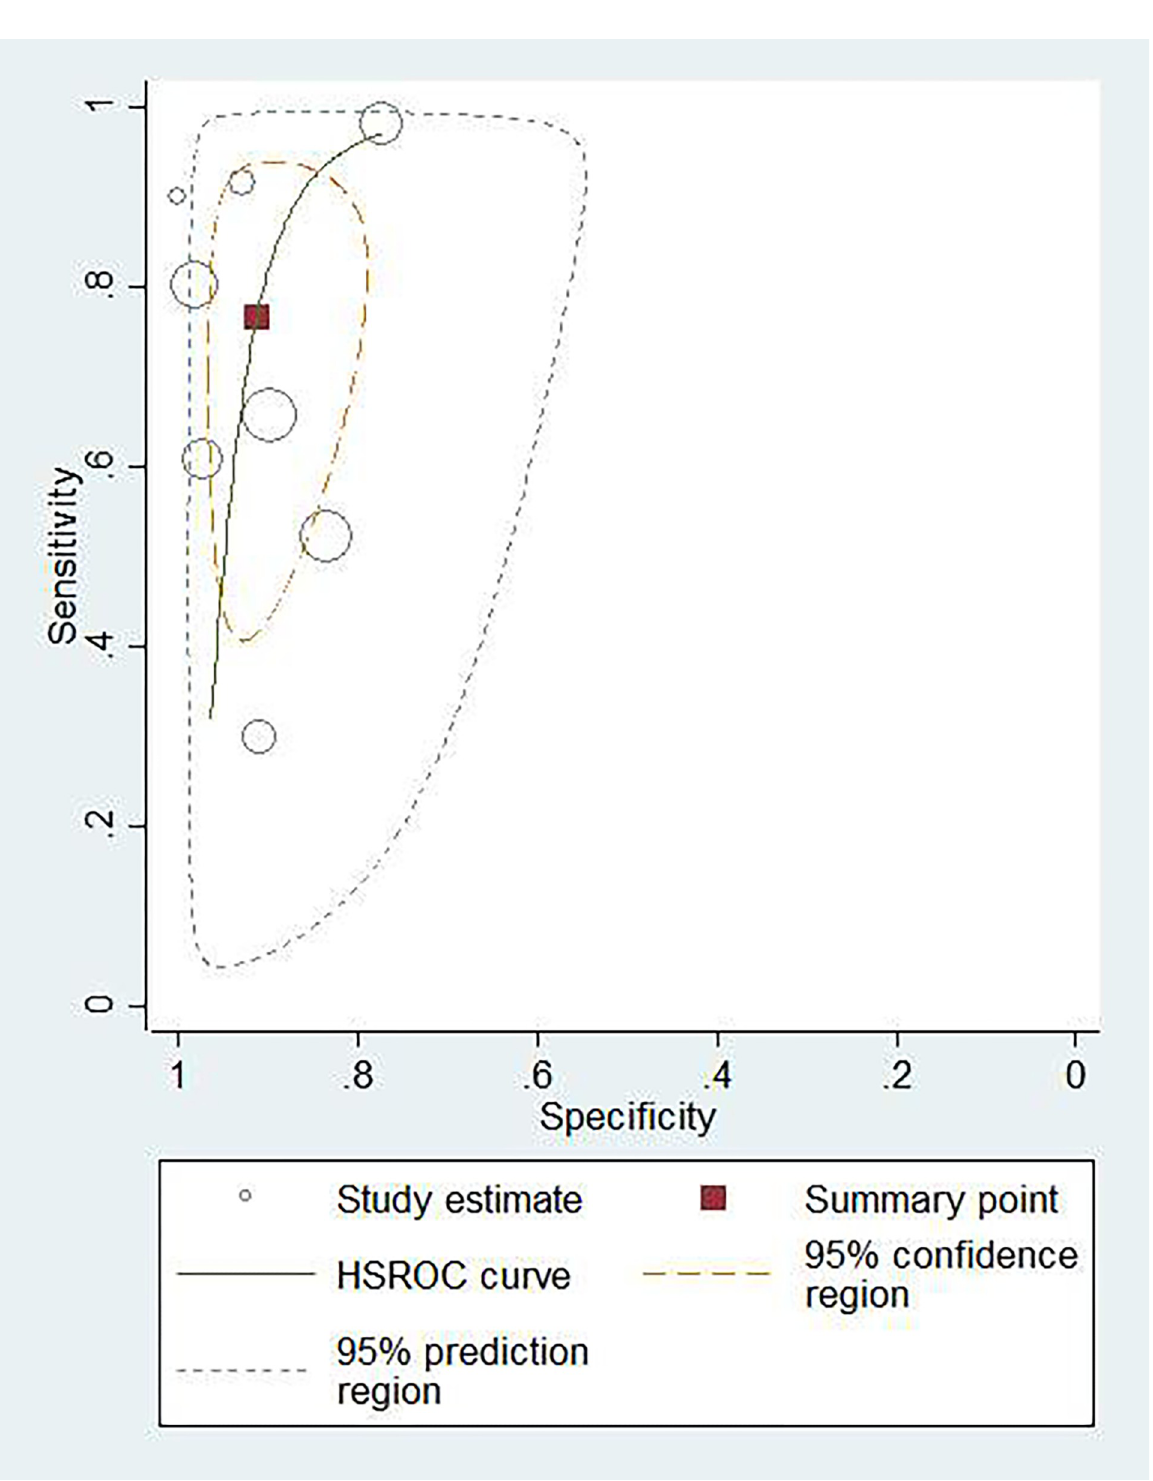
Fig 4. Hierarchical summary receiver operating characteristic (HSROC) plot to summarize diagnostic accuracy for CSF IGRA in diagnosing tuberculous meningitis.